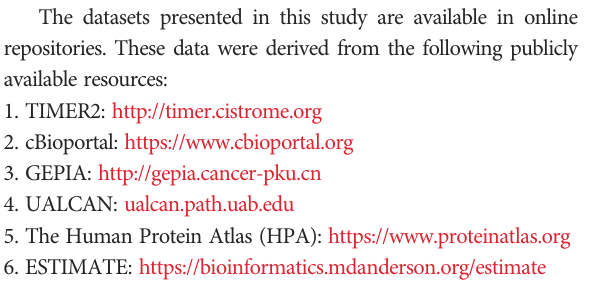
Immunohistochemical images of all the primary COAD samples in the HPA collection, 8 of the cases stained with PD-L1 (CD274) (A) and 9 of those for PSEN1 (B) . The evaluation of the PD-L1 and PSEN1 expression levels was based on the annotation parameters (upper). The staining intensity is classi fi ed into four levels, namely 0, 1+, 2+, and 3+, which are designated as negative, weakly positive, moderately positive, and strongly positive signals, respectively; The percentage of the stained cells is categorized as 0 (0%), 1(< 25%), 2 (25 – 75%) and 3 (>75%), respectively.